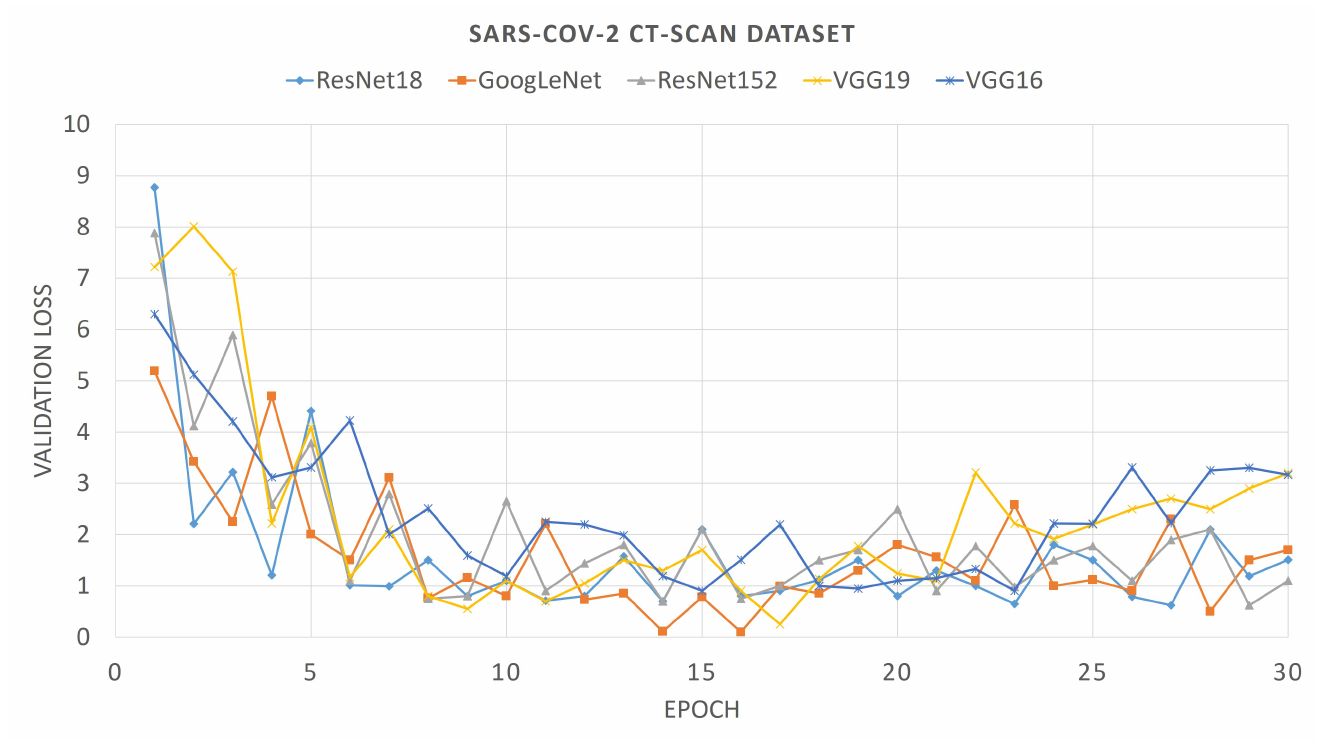
Figure 6. Loss plot of different pre-trained Convolutional Neural Networks (CNNs) on COVID